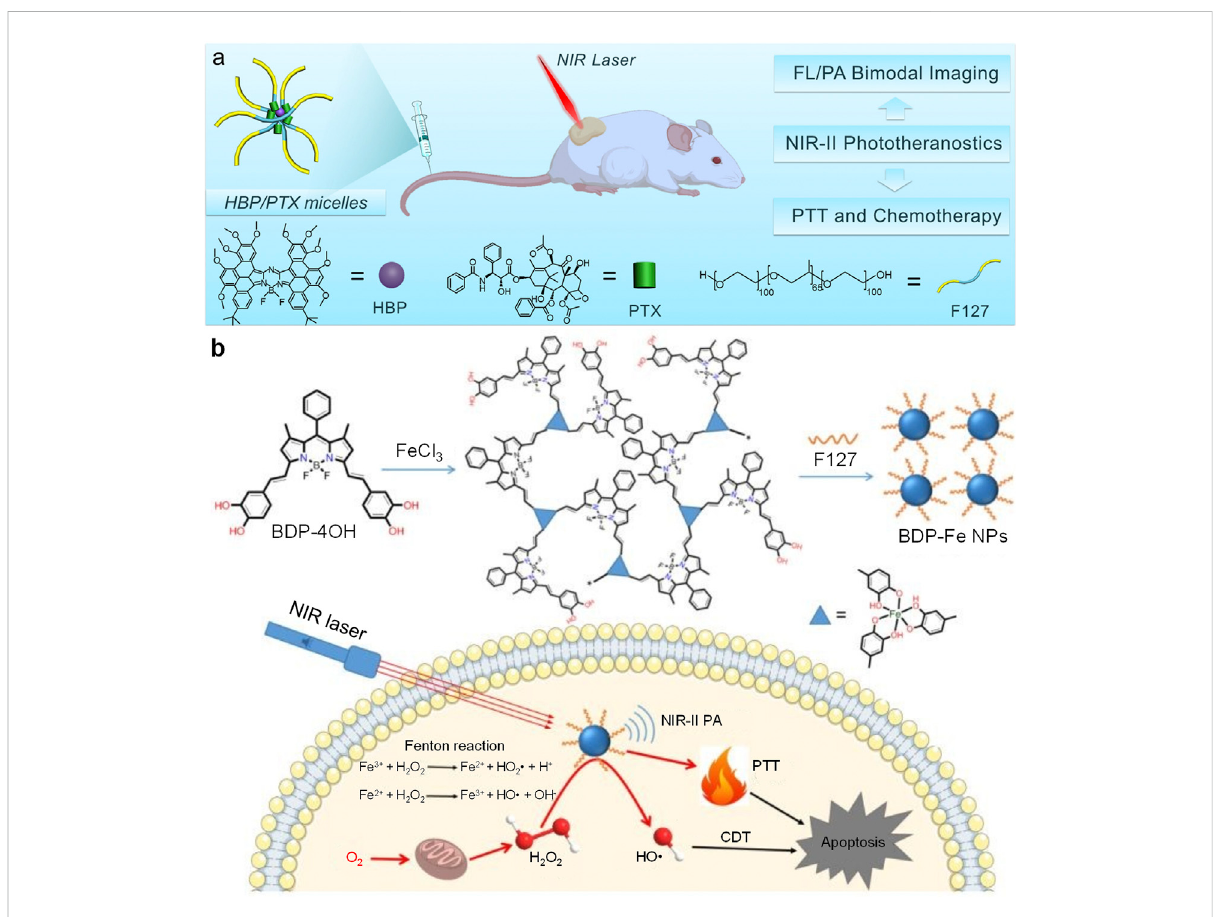
FIGURE 3 (A) Schematic illustration of structures of HBP/PTX micelles and their all-in-one NIR-II phototherapeutics for NIR-II fl uorescence/PA imaging- guidedPTT andchemotherapy. (B) Schematic illustrationofpreparation of BDP-FeNPs and their applications for NIR-II PA imaging-guided PTT